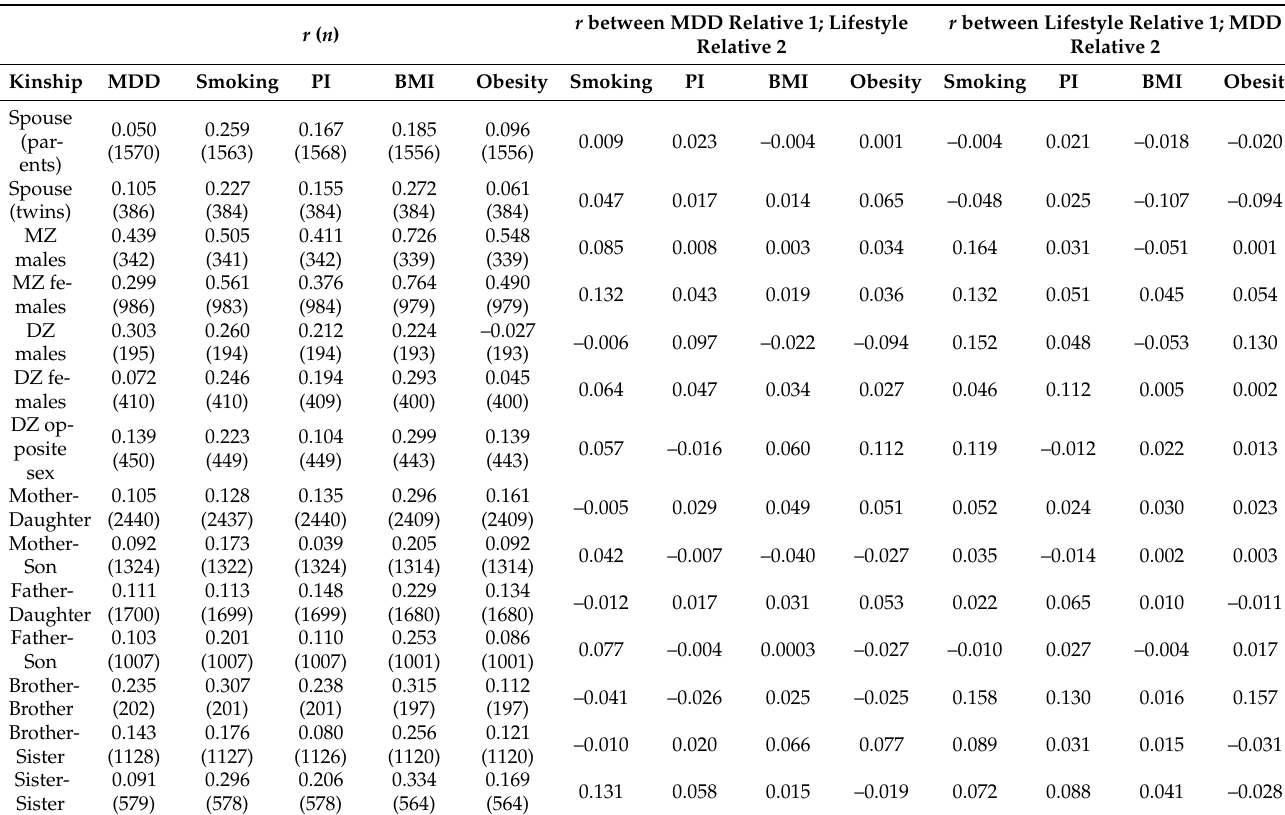
Table 3. Within- and cross-trait kinship correlation estimates for various kinships with valid lifetime major depressive disorder data in the extended twin pedigree. MDD = major depressive disorder; PI = physical inactivity; BMI = body-mass index; MZ = monozygotic twins; DZ = dizygotic twins. r between MDD Relative 1; Lifestyle r between Lifestyle Relative 1; MDD r ( n ) Relative 2 Relative